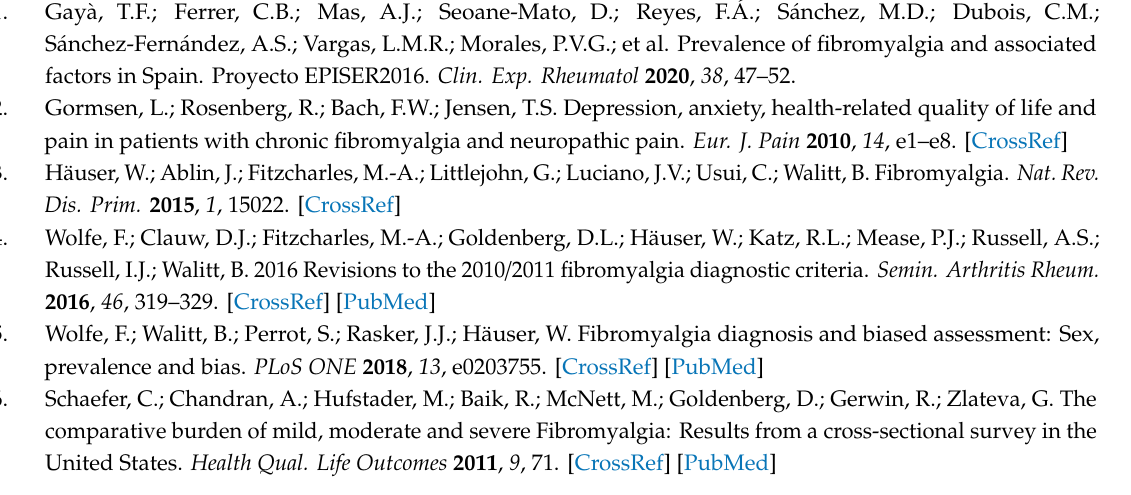
Table S1: correlation table between pre-six week changes in process variables (TSK, PCS, PPCS and CERQ) and pre-post changes in main